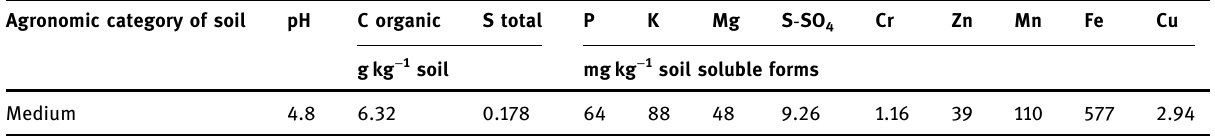
Table 1: Physical – chemical soil properties